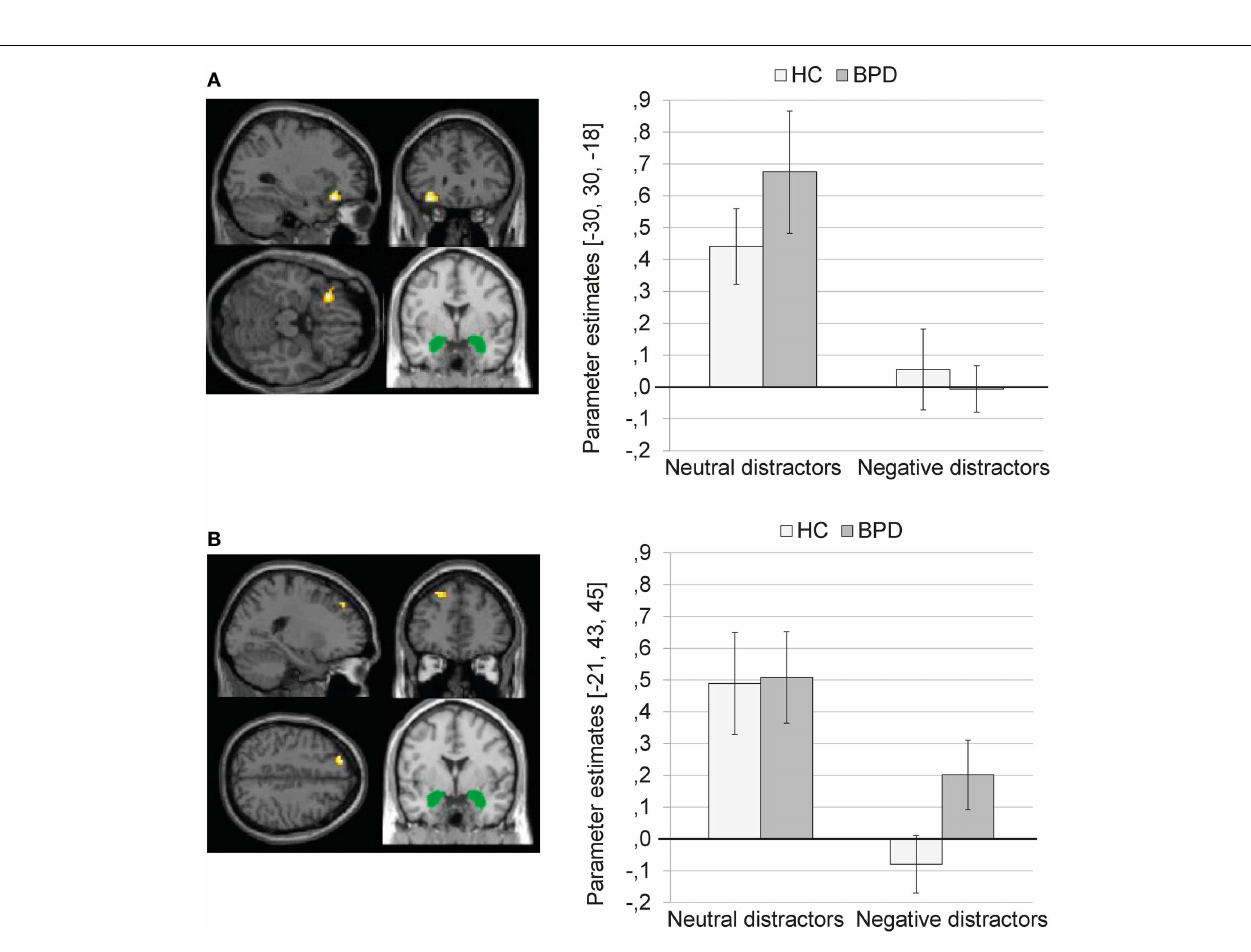
personality disorder (BPD) and healthy controls (HC). (B) Means ± SEM of parameter estimates for amygdala connectivity with left superior frontal gyrus (MNI: − 21, 43, 45) during presentation of neutral and negative distractors in BPD patients and HC.